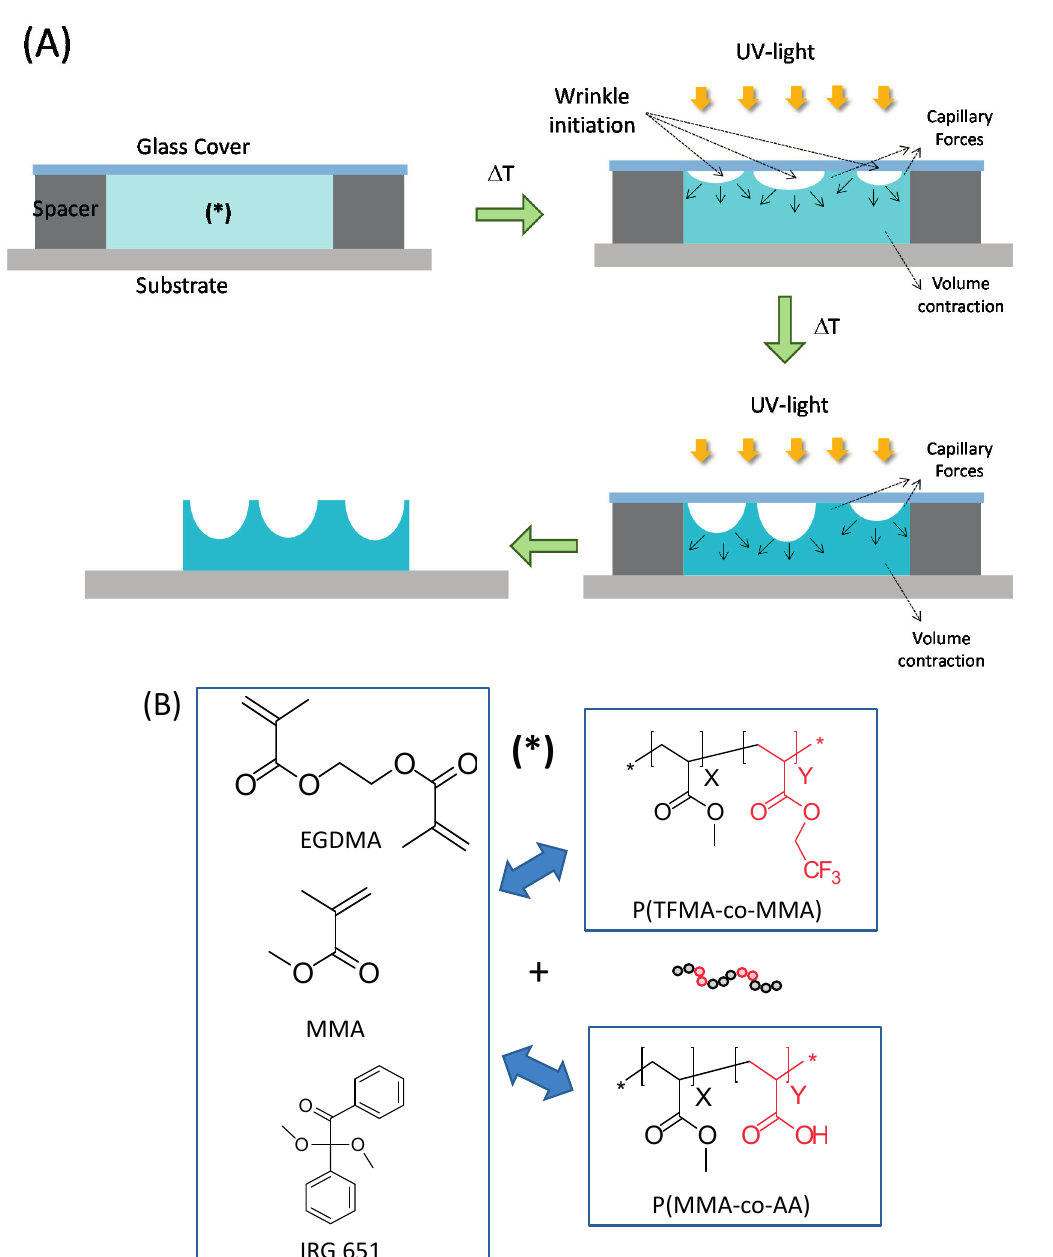
Figure 1. ( A ) Schematic illustration of the experimental procedure to fabricate wrinkled surfaces. A confined photosensitive mixture is irradiated and heated at the same